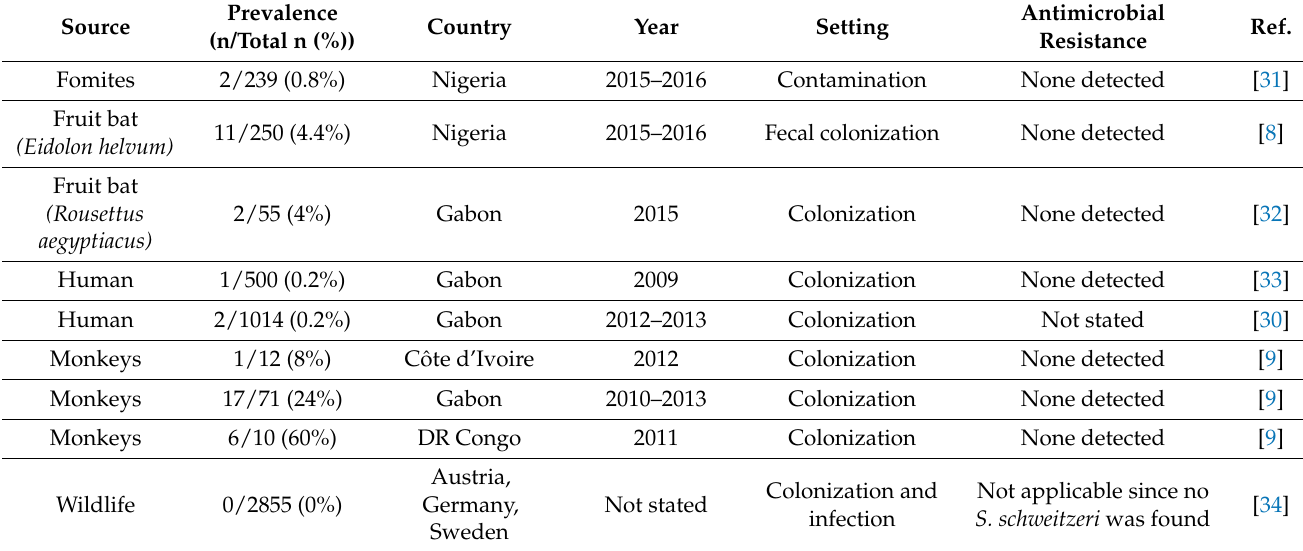
Table 1. Prevalence of Staphylococcus schweitzeri in humans and